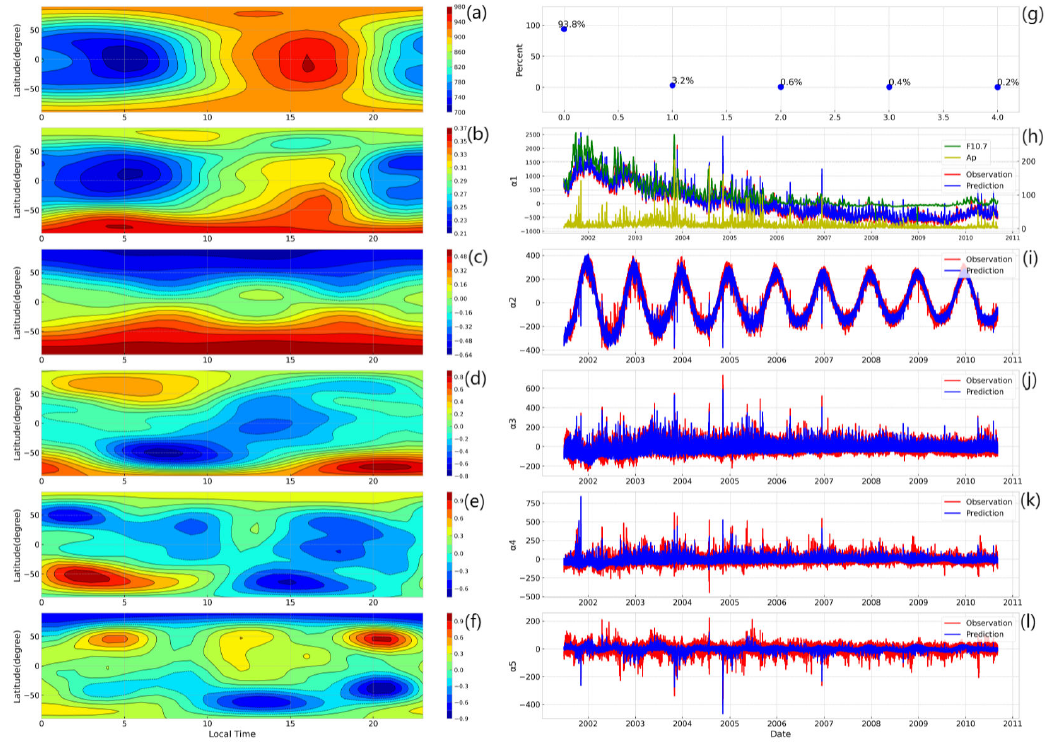
Figure 3. ( a ) The mean exospheric temperature, and ( b – f ) the first five EOFs as a function of local time and latitude. ( g ) The relative contribution of each EOF to the total variability of exospheric temperature. ( h – l ) The amplitudes (blue lines) and their fitting results (red